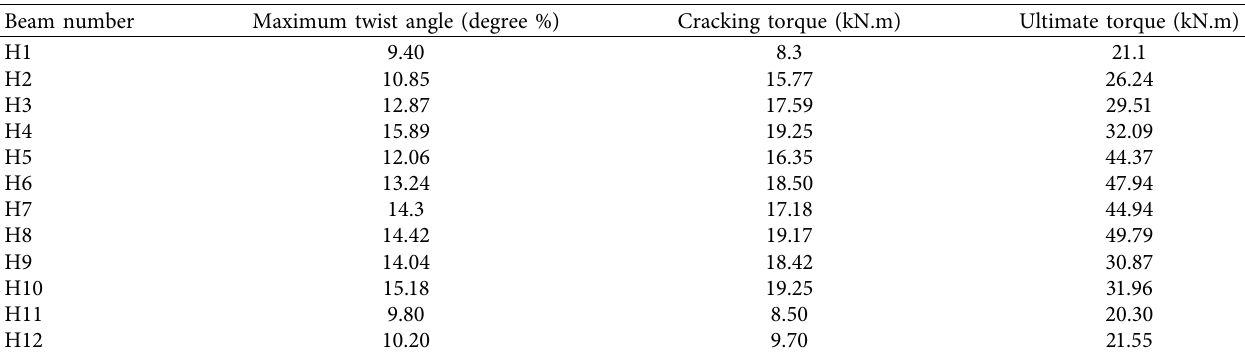
Table 6: The overall results of tested